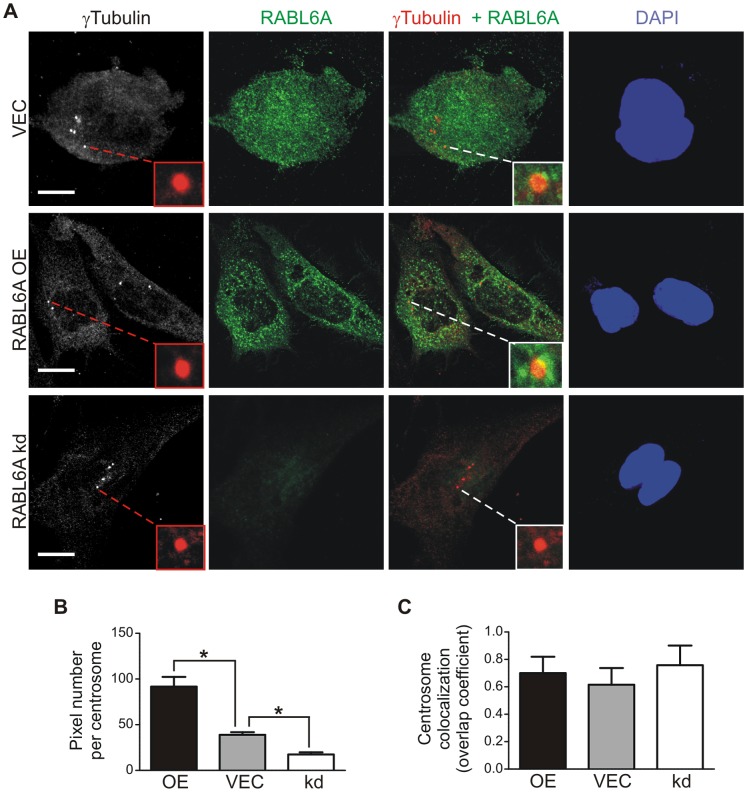
RABL6A is a novel centrosomal protein.p53−/− MEFs infected with retroviruses expressing empty vector (VEC),wild-type RABL6A (OE) or RABL6A shRNAs (kd) were stained with antibodies to RABL6A and γ-tubulin. (A) Representative confocal images show γ-tubulin (grey or red), RABL6A (green) and DAPI-stained nuclei (blue). Merged images show γ-tubulin in red with overlap between the proteins at centrosomes appearing orange to yellow. Insets magnify individual centrosomes. Scale bar, 10 µm. (B) Quantification of RABL6A-positive pixels per centrosome in cells from (A). Error bars, SEM; *, p<0.0001 as calculated using paired, two-tailed Student’s t-test. (C) Quantification of the mean weighted overlap coefficients for centrosome co-localization of γ-tubulin and RABL6A in cells from (A). Error bars, standard deviation from the mean.